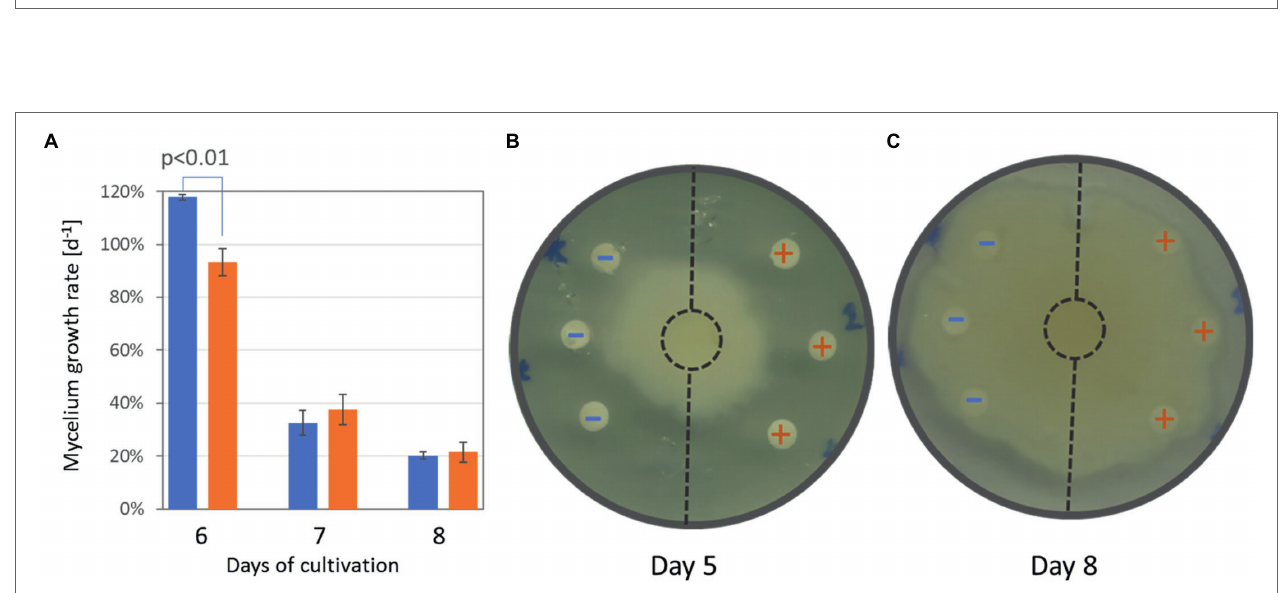
FIGURE 7 | Accumulation of bioactive molecules and protectants in response to T. calospora . (A) Integration of metabolomic and proteomic data. Joint pathway analysis by MetaboAnalyst 5.0. (B) Estimation of total phenolic content. GAE, gallic acid equivalents. Data represent the means and standard deviation of at least four biological replicates (tubers of four inoculated plants and five mock-treated controls). (C) Expected metabolic flux based on integration of proteomics and metabolomics data. Statistically significant differences (Student’s t -test) at p < 0.1 (*) and p < 0.01 (**). (D) Relative auxin content in orchid tubers. Data represent the means and standard deviation of at least four biological replicates (tubers of four inoculated plants and five mock-treated controls) and were normalized to the auxin content in mock-treated tubers (48 ± 42 ng g − 1 DW). For details, see Supplementary Tables 2 and 3 .